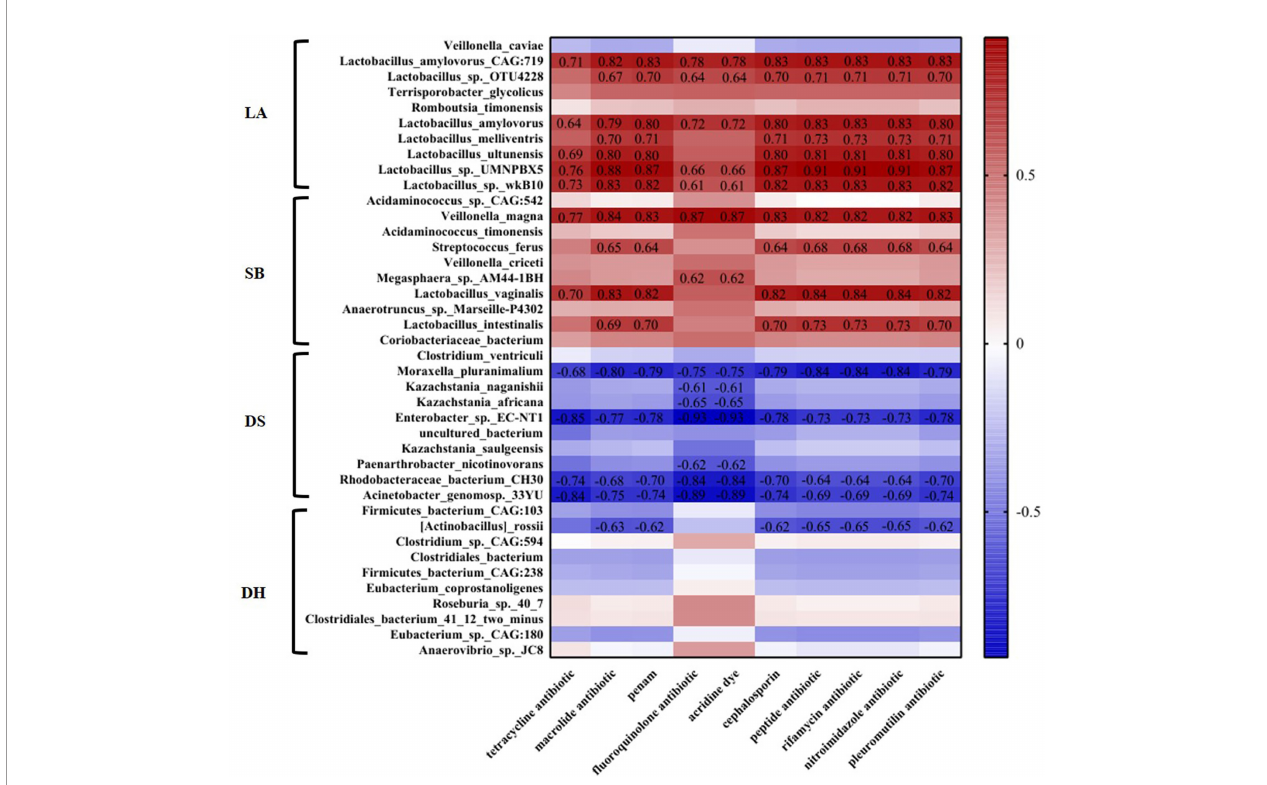
FIGURE 7 | Heatmap analysis of the abundance of top ten differential microorganisms and different categories ARGs in different pig breeds. Correlation of p < 0.05 are shown. The number in the fi gure represents R value.